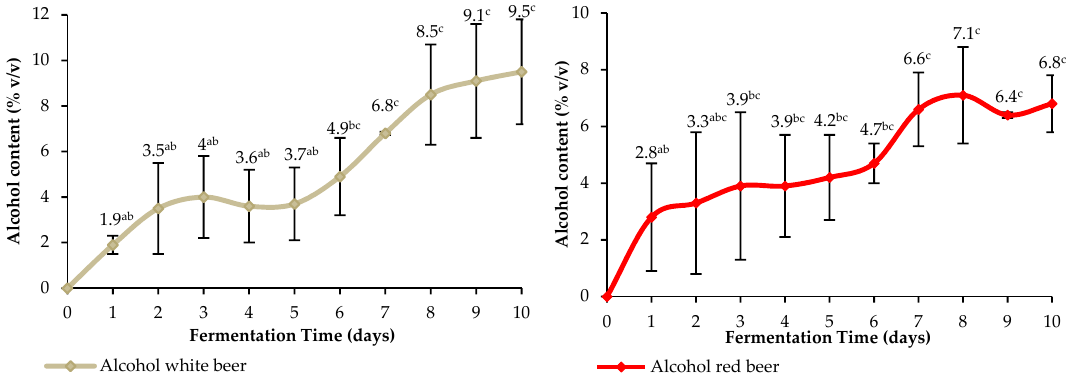
Figure 2. Evolution of alcohol content during fermentation of the indigenous sorghum beers. Mean values ( n = 3 repetitions) preceded by at least one common letter (a, b, c) were not significantly different ( p < 0.05). Bars represent standard deviations.